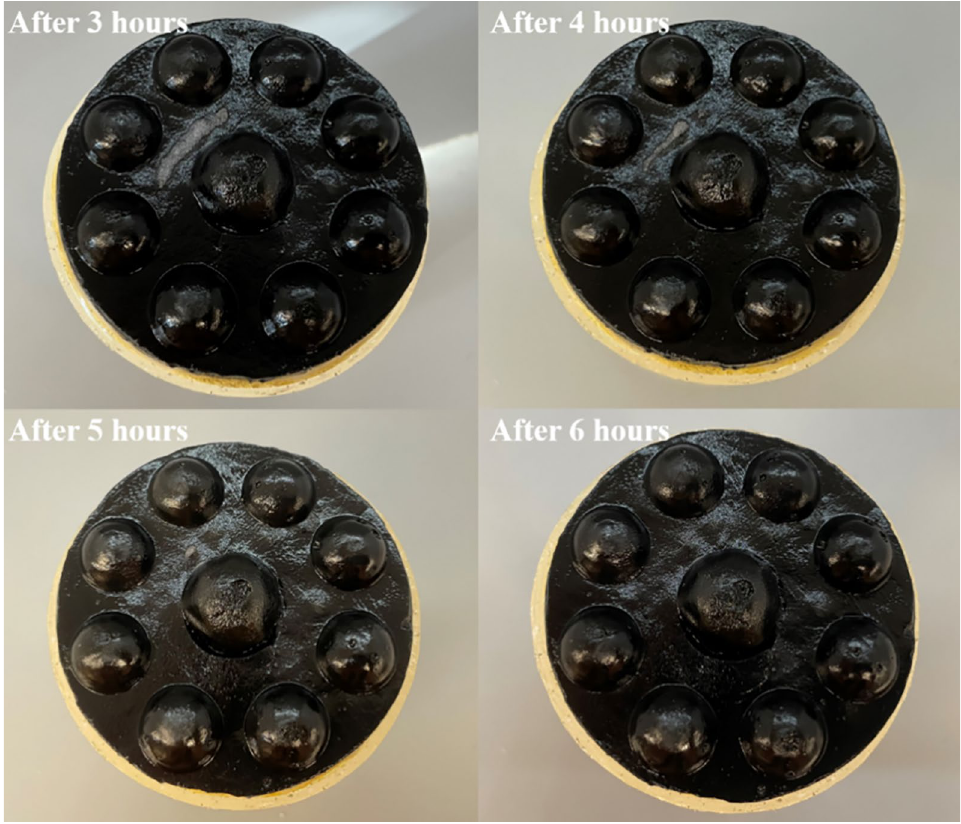
Figure 7. The salt rejection progress of the dome-arrayed chitosan/PVA hydrogel based evaporation